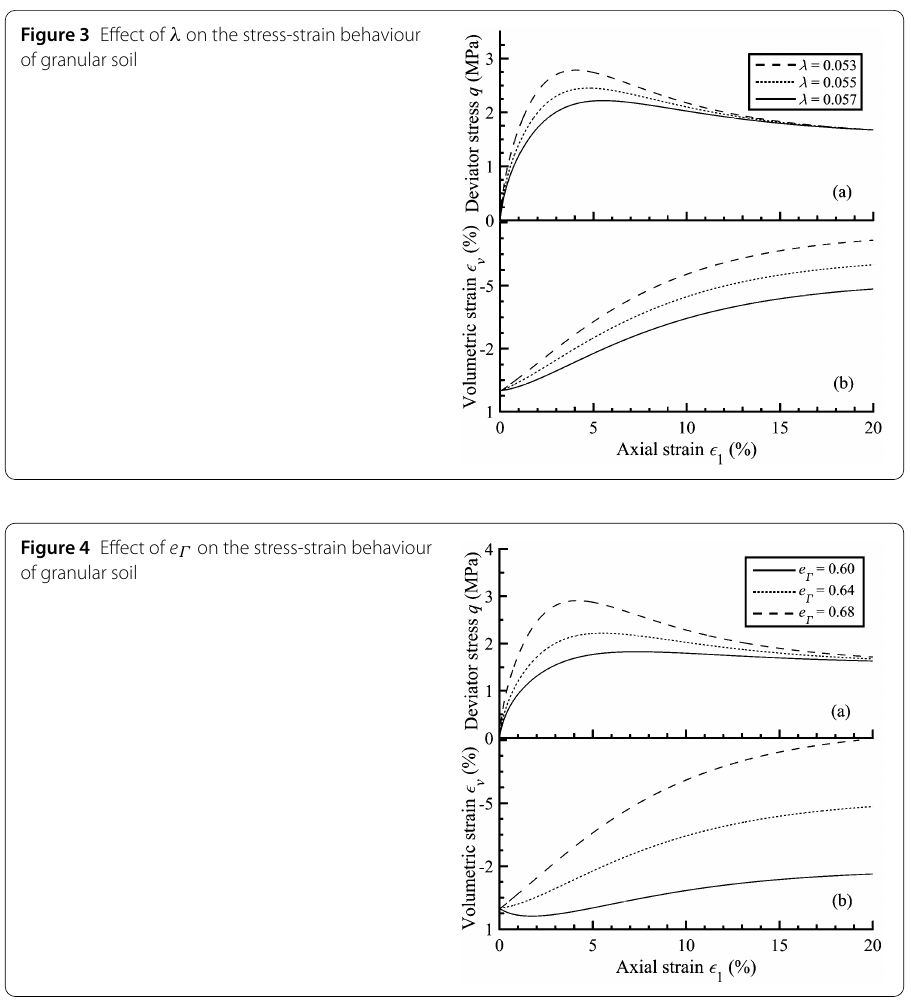
Figure 3 Effect of λ on the stress-strain behaviour of granular soil